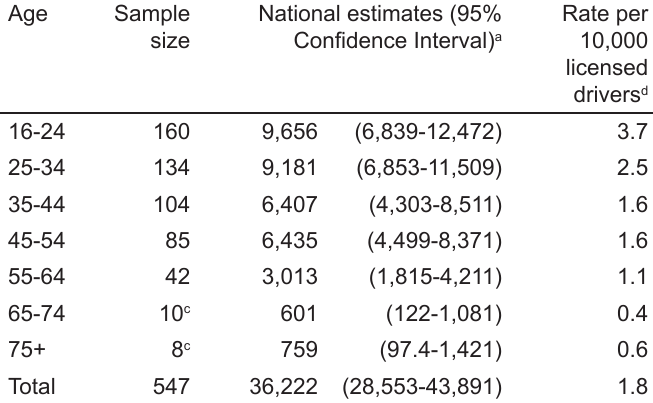
Table 4. Rates of motor vehicle crash-associated eye injuries among licensed drivers in the U.S.